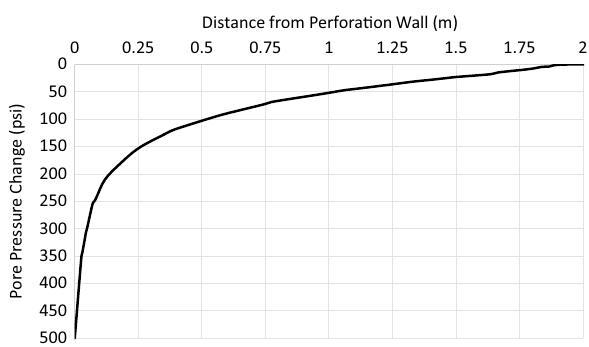
Fig. 23 Pore pressure change (psi) profile from perforation wall for a drawdown pressure of 500